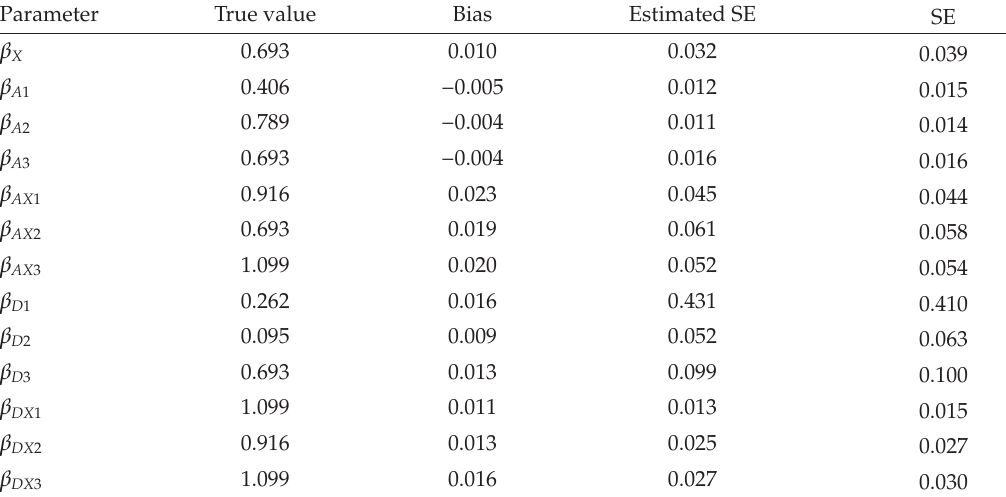
Table 3: Biases and root mean squared errors (cid:3) RMSEs (cid:4) of risk parameters obtained based on asymptotic posterior distribution. The results are based on 500 samples of 1,500 cases and 1,500 controls. Genotype is (cid:7) 0 . 25, i (cid:7) 1 , 2. The environmental covariate (cid:3) X (cid:4) is binary and simulated at the two marker loci with P M i measured with error with misclassification probabilities being 0 . 20 for exposed and 0 . 25 for nonexposed subjects. The data is simulated and analyzed under the additive e ff ect model and the LD measure Δ M 1 M 2 (cid:7) 0 .